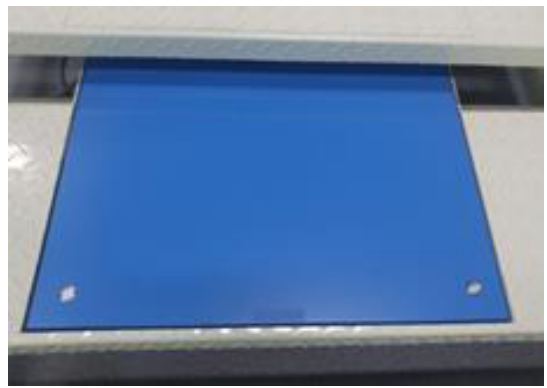
Figure 4. Ground reaction force plate.